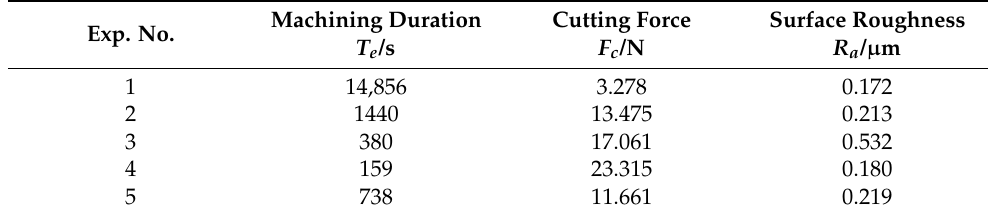
Table 3. Experimental results of the face milling of the HKMU. Exp.